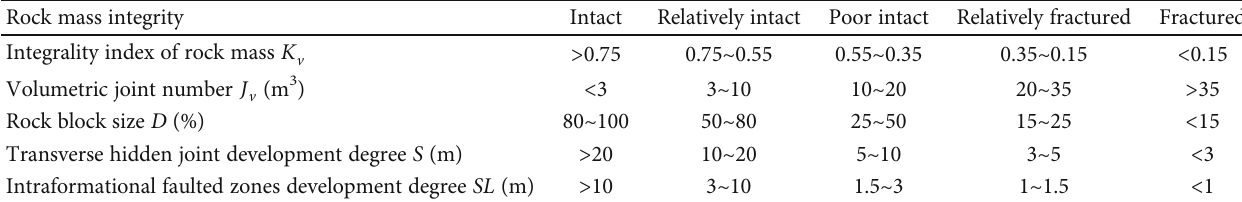
Table 4: Rock mass integrity classi fi cation.